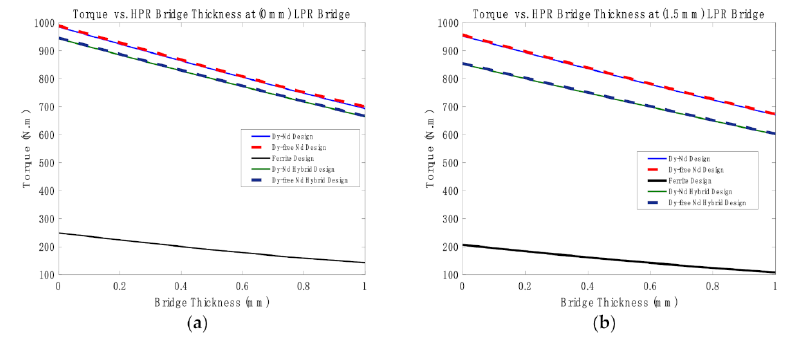
Figure 7. Reduction of torque as a function of the HPR bridge at when the LPR bridge is equal to ( a ) 0 mm, and ( b ) 1.5